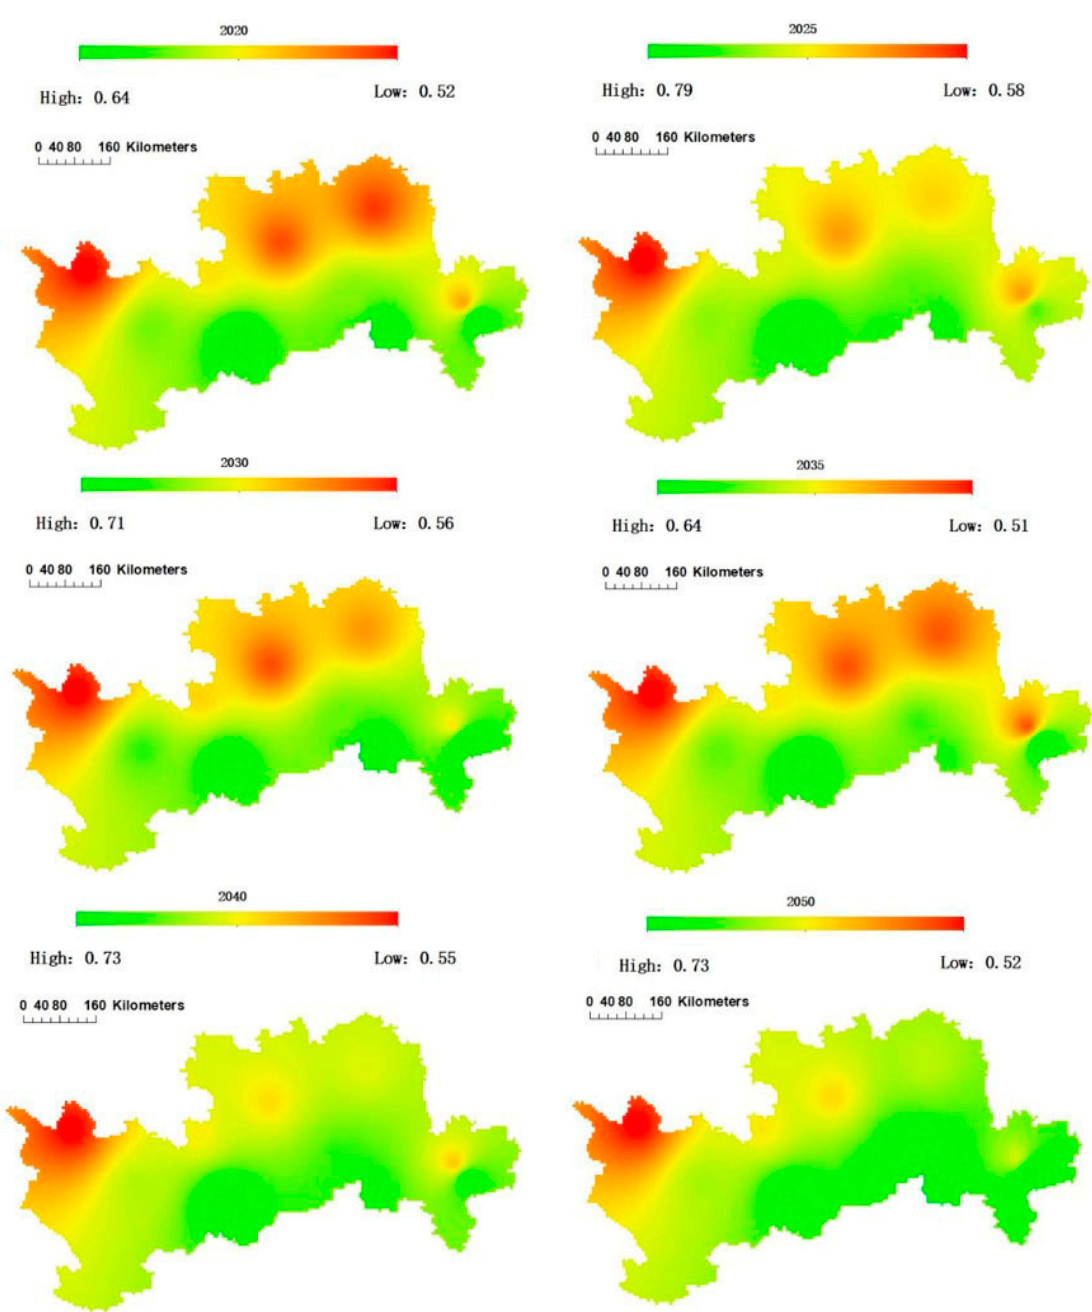
Figure 8. Spatial evolution of the water suitability of apple trees in each province from 2019 to 2050.